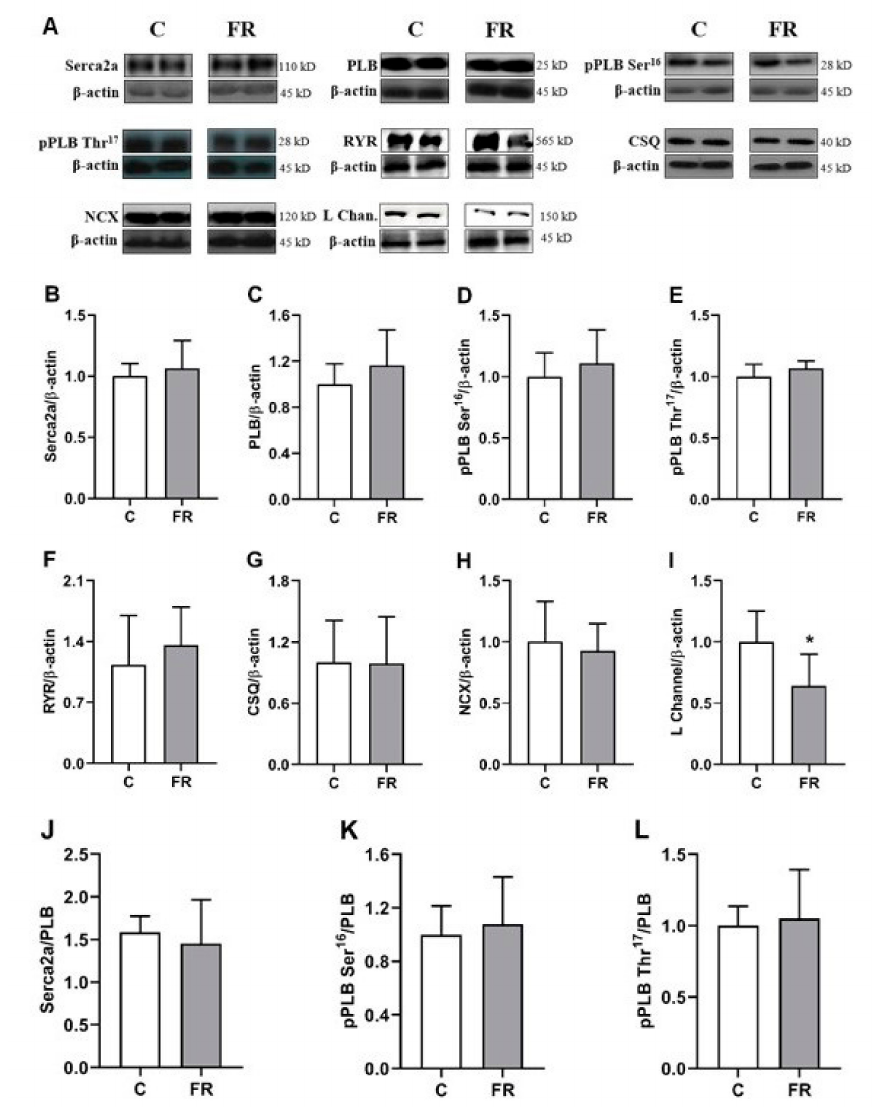
Figure 3. Protein expression of calcium-handling regulators evaluated by Western blot in the myocardium from control (C) and food restriction groups (FR) (n = 6 in each group). ( A ) Representative bands of the proteins. Quantification of myocardial ( B ) sarcoplasmic reticulum calcium-ATPase (SERCA2a), ( C ) total phospholamban (PLB), ( D ) phosphorylated PLB on serine-16 (pPLB Ser 16 ), ( E ) phosphorylated PLB on threonine-17 (pPLB Thr 17 ), ( F ) ryanodine receptor (RYR), ( G ) calsequestrin (CSQ), ( H ) sodium-calcium exchanger (NCX), and ( I ) L-type Ca 2 + channel (L Channel) normalized to β -actin (internal control). Quantification of ( J ) SERCA2a, ( K ) pPLB Ser 16 , and ( L ) pPLB Thr 17 normalized to total PLB. Data are expressed as mean ± standard deviation. Student’s t -test for independent samples. * p < 0.05 vs.